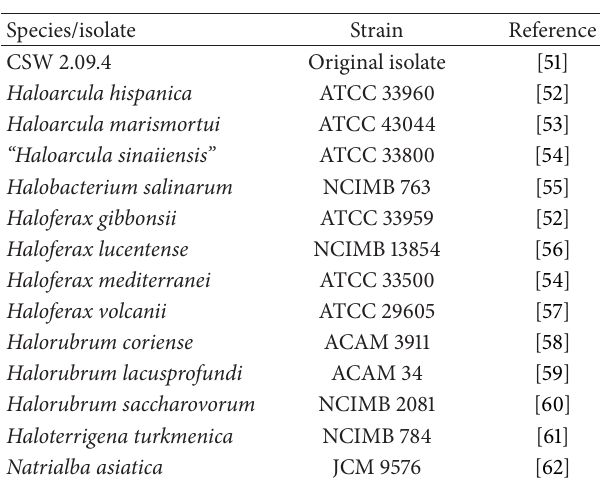
Table 1: Strains used in this study.